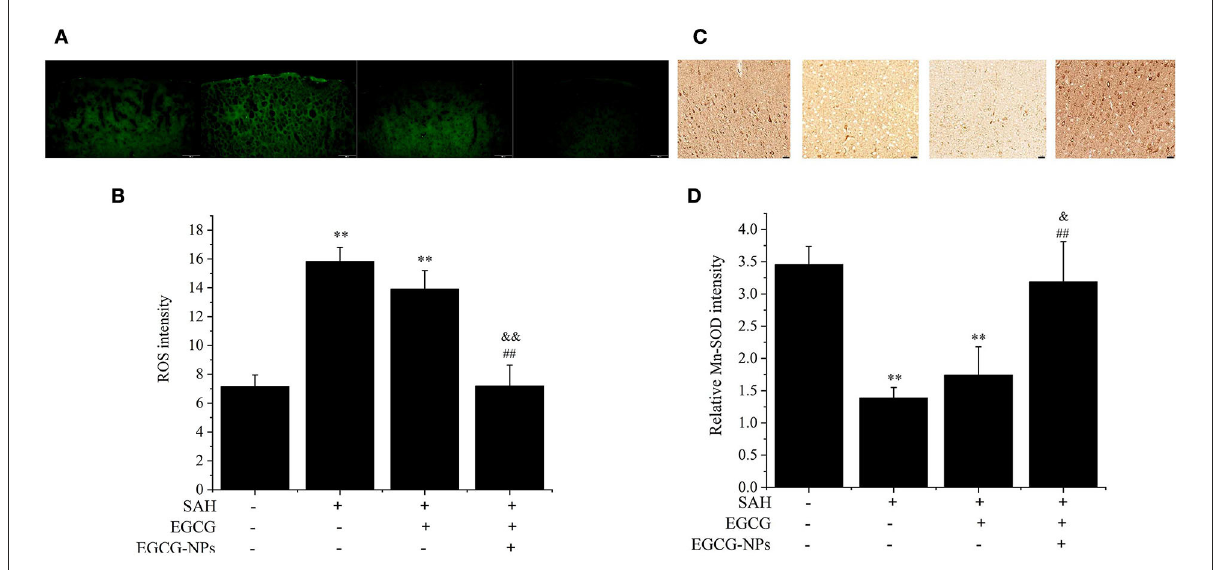
FIGURE5 Effects of EGCG-NPs on the mitochondrial oxidative stress after SAH. ROS fluorescence distribution in the brain detected by fluorescence microscopy (A) . Quantification of ROS fluorescence intensity after SAH (scale bar = 100 µ m) (B) . Identification of the expression of Mn-SOD by the immunohistochemical assay (scale bar = 20 µ m) (C) . Quantification of the Mn-SOD level by densitometry (D) . Quantification represents the means and standard deviations of the results from three independent experiments. ** P < 0.01 vs. Sham; ## P < 0.01 vs. SAH; & P < 0.05 vs. EGCG; && P < 0.01 vs.